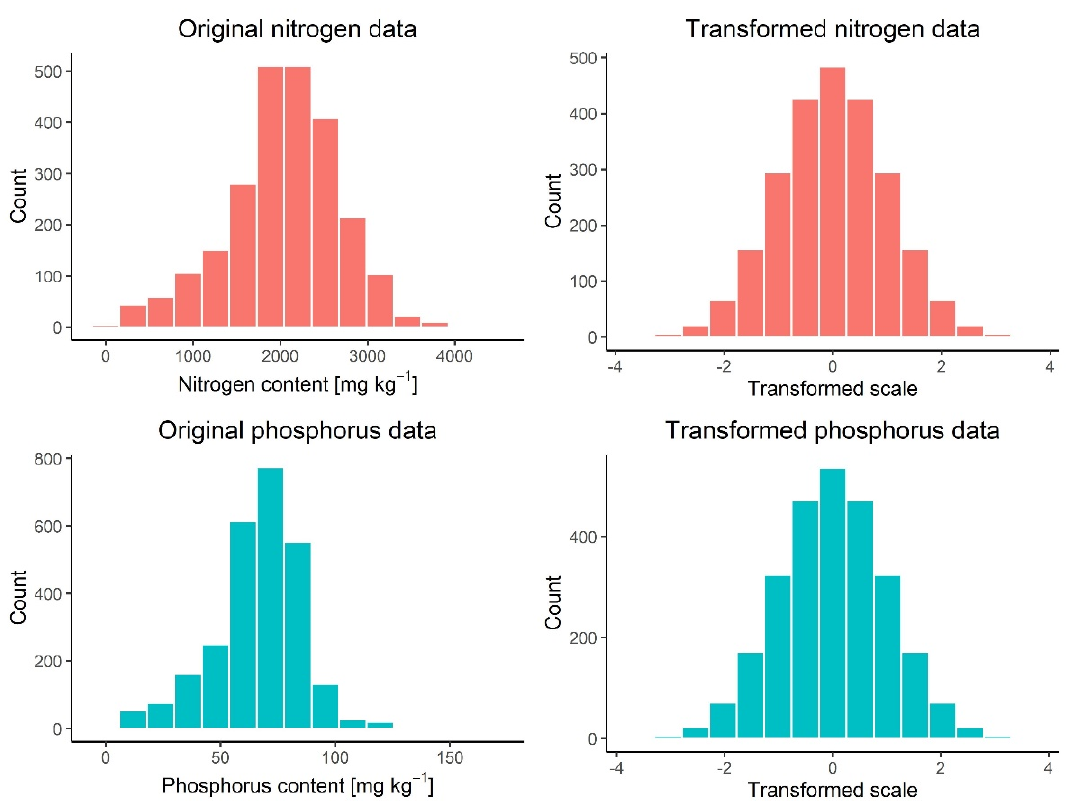
Figure 3. Histograms of the original ( left column ) and transformed ( right column ) data on the nutrients nitrogen and phosphorus. Annotation: the transformed data have a standard normal distribution for both nutrients with zero mean and unit variance.